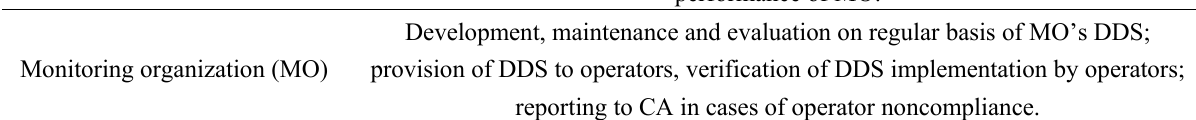
Table 1. Responsibility and position of the studied company (operator) according to the EUTR [36]. Actor Responsibility Operator Maintenance, update, and evaluation of DDS (except DDS developed by MO). Control over EUTR implementation in EU member state, verification of Competent authority (CA) performance of MO. Development, maintenance and evaluation on regular basis of MO’s DDS; Monitoring organization (MO) provision of DDS to operators, verification of DDS implementation by operators; reporting to CA in cases of operator